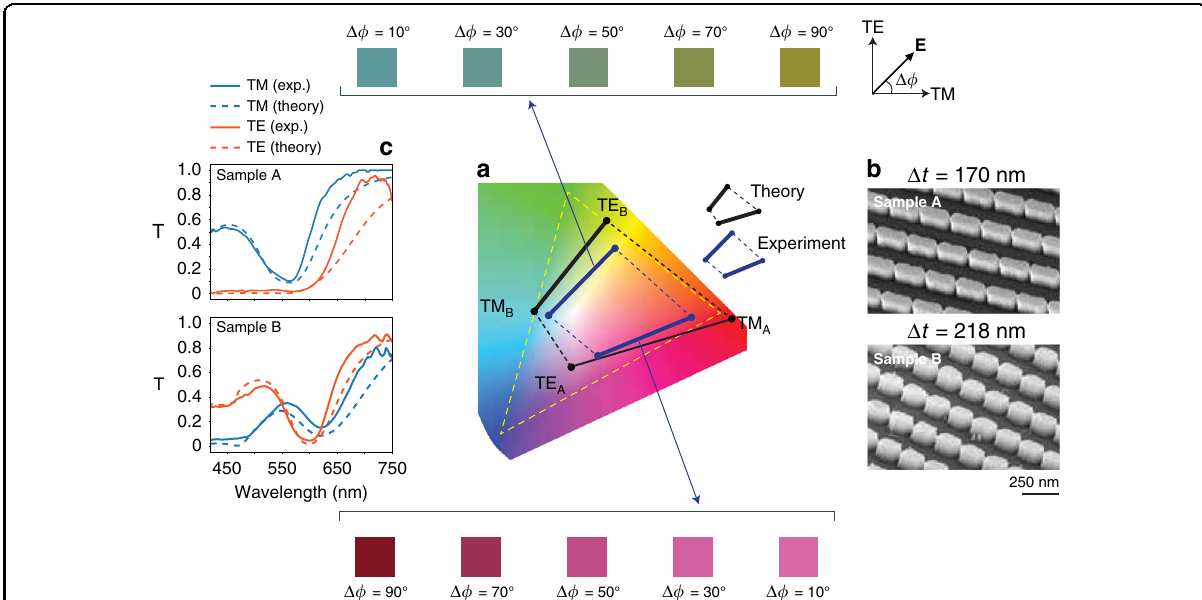
Fig. 7 Characterization of the fabricated two-subpixel colour samples. a Theoretical (black rhomboid) and experimental (blue rhomboid) chromaticity gamut of samples A and B illustrated in the SEM images of panel ( b ). The corresponding colours for different input polarization angles Δ ϕ are shown in panel ( a ). c FDTD-calculated theoretical transmission ( T ) response (dashed line) compared to experimental measurements (solid